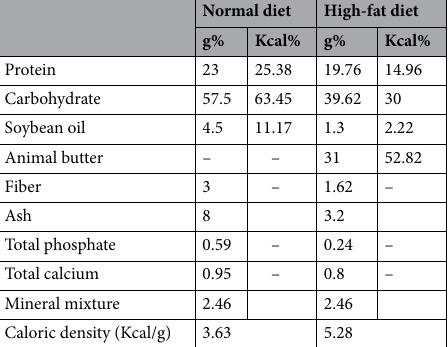
Table 1. Composition of normal diet and high fat